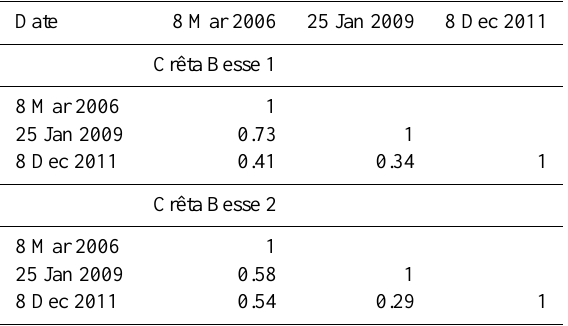
Table 4. Coefficient of determination ( R 2 ) of correlations between snow depth distributions in the CB1 and CB2 basins ( p <